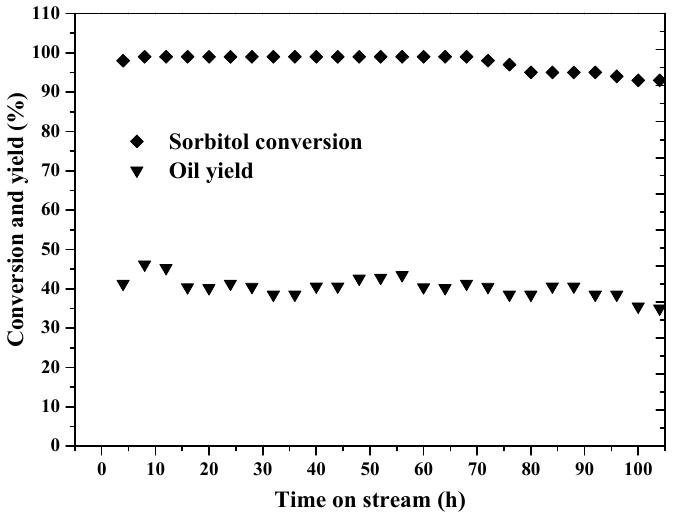
Figure 6. Sorbitol conversion and oil yield as the function of reaction time. Reaction conditions: 20 wt. % sorbitol aqueous solution, 593 K, 4 MPa H 2 pressure, 4 g